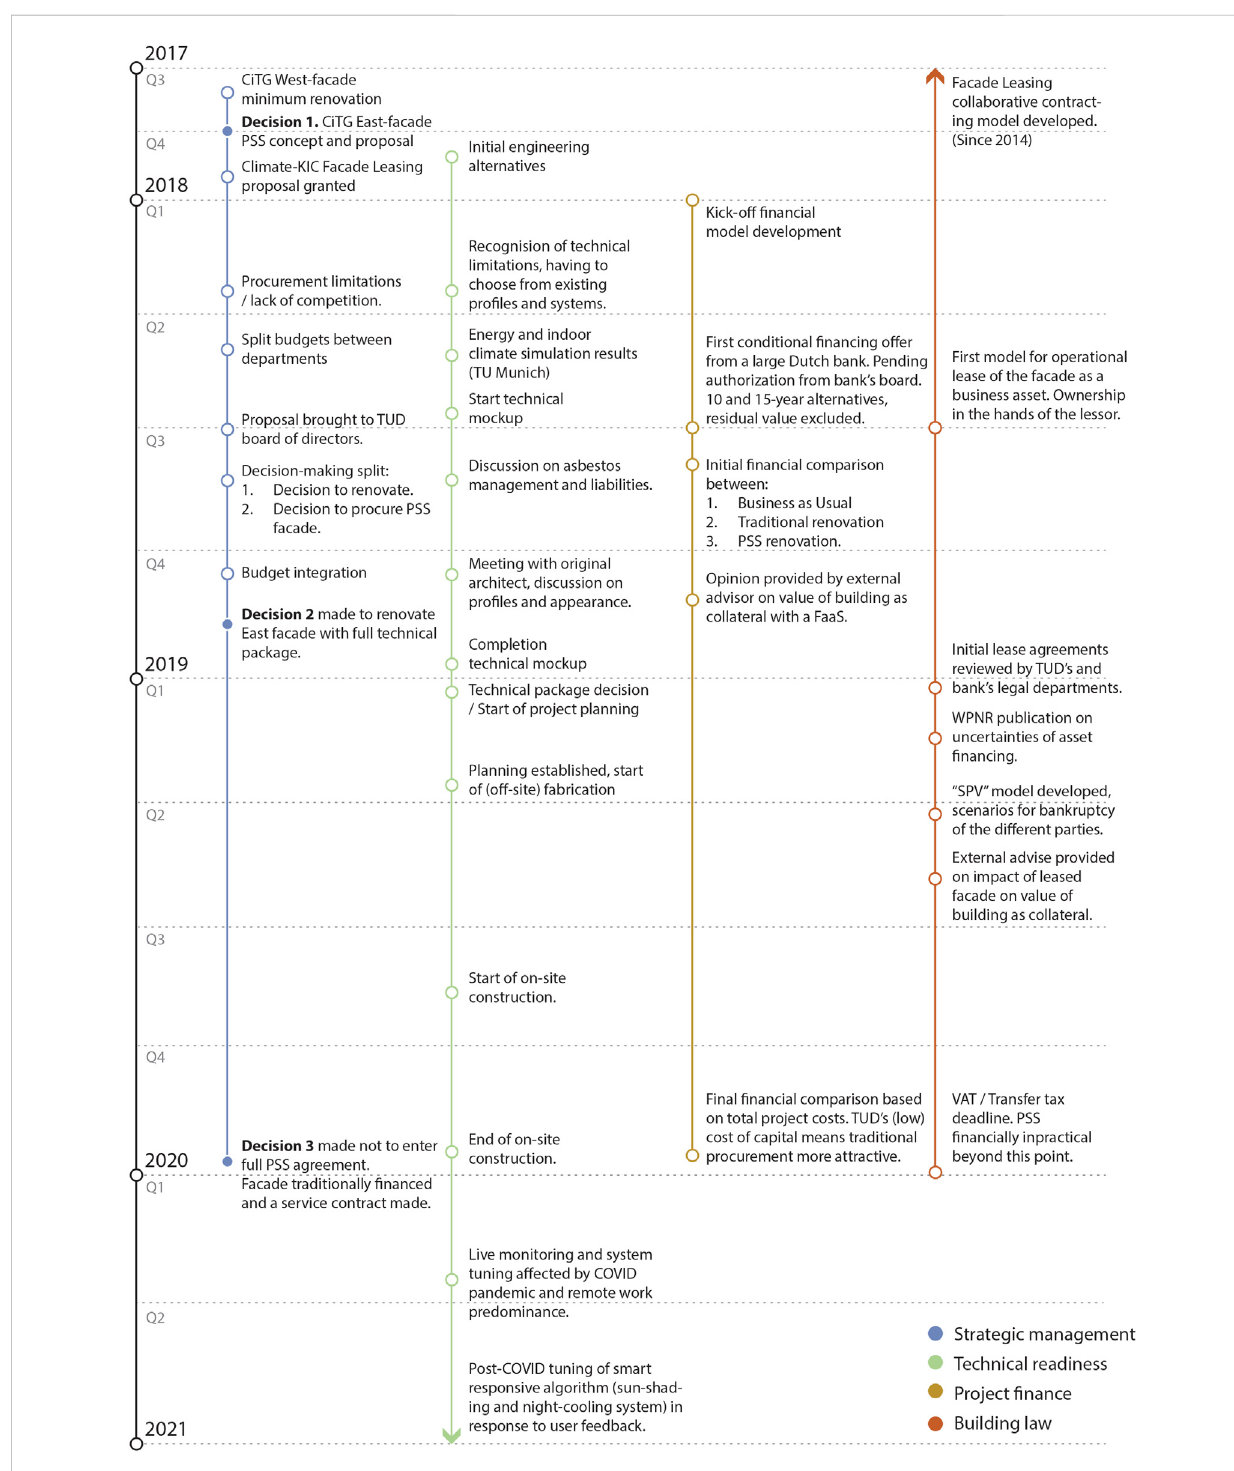
FIGURE 2 Timeline for the CiTG East façade renovation decision-process, and the several multi-disciplinary discussions and milestones contributing to these